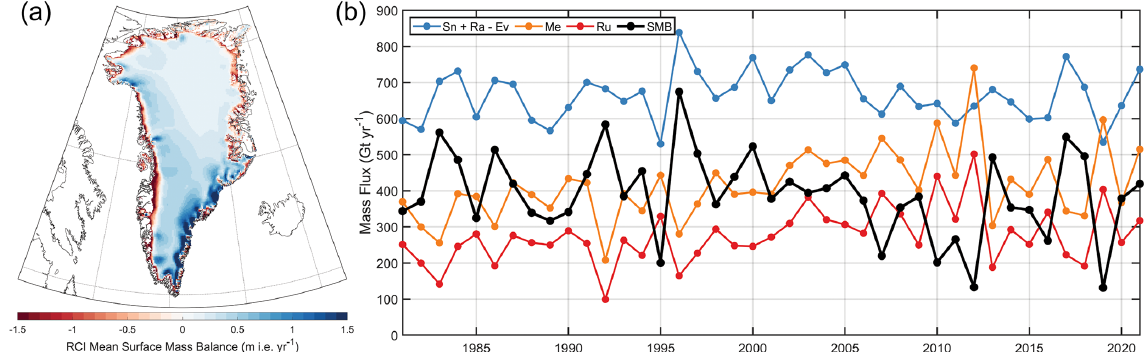
Figure 14. (a) The mean annual surface mass balance of the Greenland Ice Sheet and its peripheral ice over the reference climate interval (RCI: 1980–1995). (b) Time series of annual SMB (black) and its components (see Eq. 5) for the Greenland Ice Sheet only. Net accumulation (blue) and runoff (red) are combined to make SMB. Meltwater production is in yellow. The annual values are calculated from October through September and are defined by the year of the